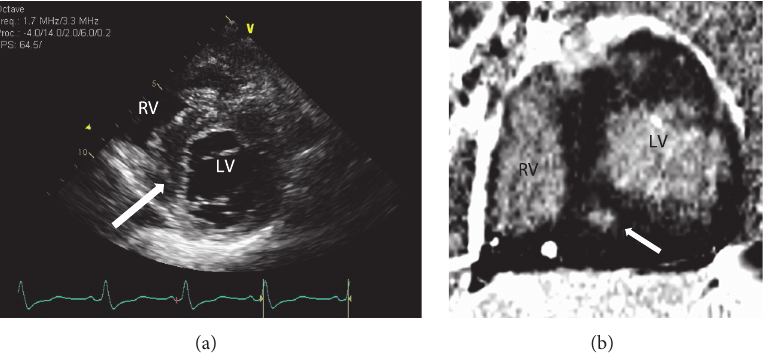
Figure 4: Sample short axis images from echocardiography (a) and cMRI (b) performed on a 12-year-old female patient with HCM demonstrating a false negative result on echocardiography. (a) demonstrates no corresponding focus of hyperechogenicity (white arrow) within the septal myocardium, which is apparent on cMRI (b) that confirms the presence of LGE within the same location indicating fibrosis. (RV: right ventricle and LV: left